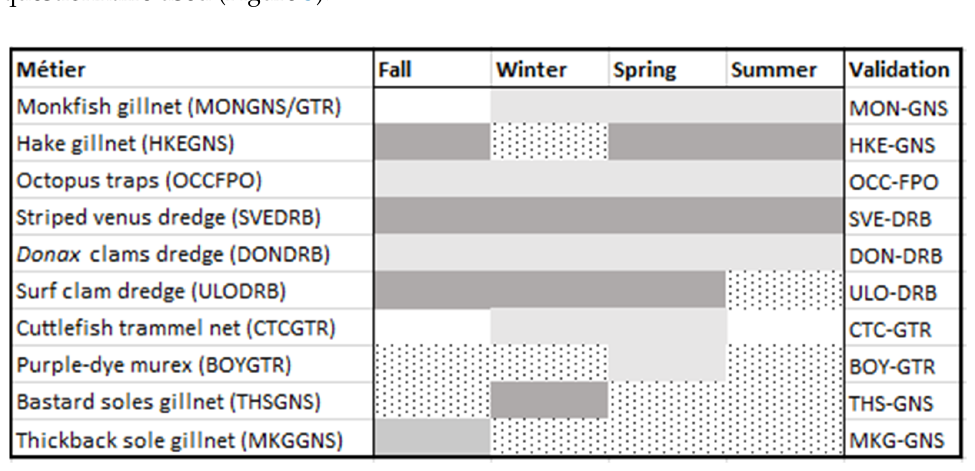
Figure 3. Métiers (common name, gear type, FAO code, and DGRM gear abbreviations) with the characteristic season (in which the highlighted seasons represents an overlap with the landing profile potential métiers from 2012–2016 and the dotted pattern solely represents the questionnaire responses), and validated metiers.